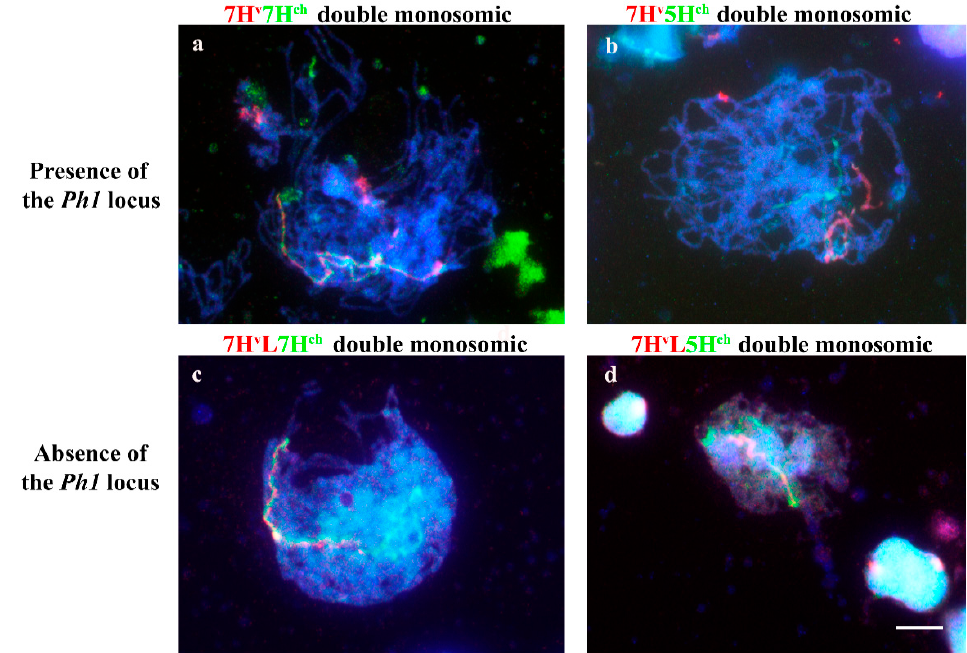
Figure 2. Analysis of pairing between homoeologous and non-homoeologous barley chromosomes during early meiosis in the presence and in the absence of the Ph1 locus. Hordeum vulgare (red) and H. chilense (green) chromosomes. DNA was counterstained with DAPI (blue). ( a ) 7H v 7H ch double monosomic addition line showing both barley chromosomes associated at early pachytene in the presence of the Ph1 locus. ( b ) Non-homoeologous 7H v and 5H ch did not associated in the presence of the Ph1 locus. ( c ) 7H v L7H ch double monosomic addition mutant line showing both barley chromosomes associated by the long chromosome arm at early pachytene in the ph1b mutant background. ( d ) 7H v L5H ch double monosomic addition mutant line showing both barley chromosomes partially associated at early pachytene in the ph1b mutant background. Bar: 10 µ